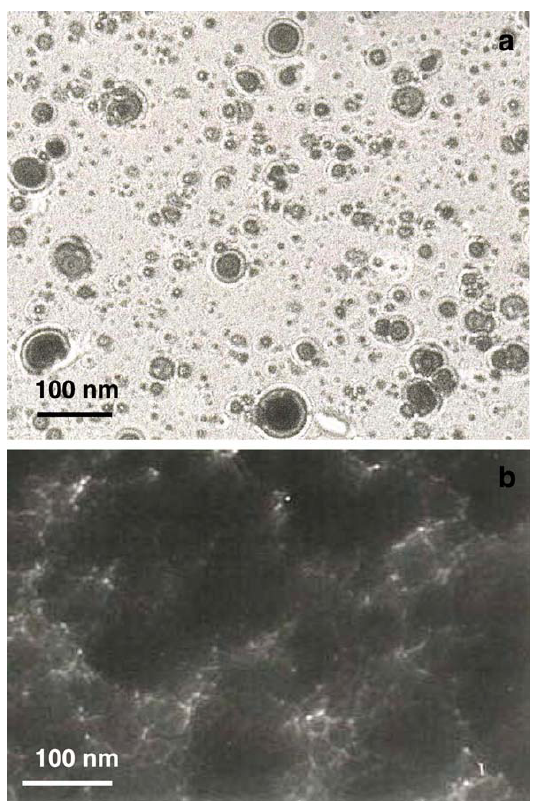
Figure 7. TEM microphotographs of ( a ) TiC film using a 5 min deposition at a distance of 2.0 cm from the target; ( b ) TiC film using a 30 min deposition at a distance of 2.0 cm. Reprinted with permission from [29], copyright 2006 Elsevier.